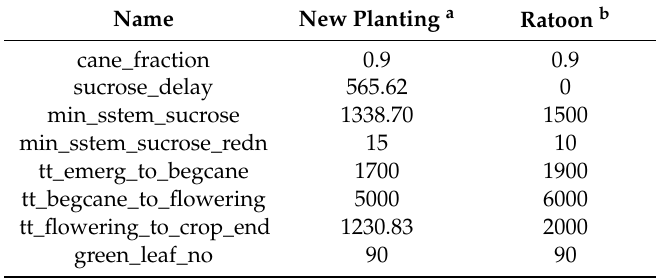
Table 10. Values of crop variety parameters after model parameter calibration. Name New Planting a Ratoon b